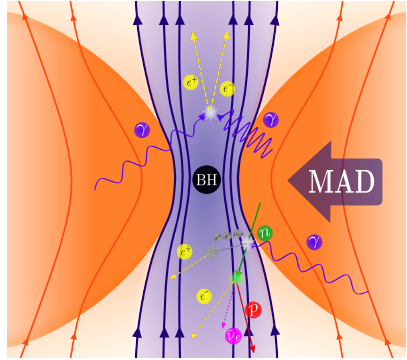
Figure 3. Cartoon showing the different components of a MAD flow onto a black hole and the main particle injection mechanisms at the base of the jet: injection of pairs via photon annihilation and injection of baryons (protons) via neutron-driven